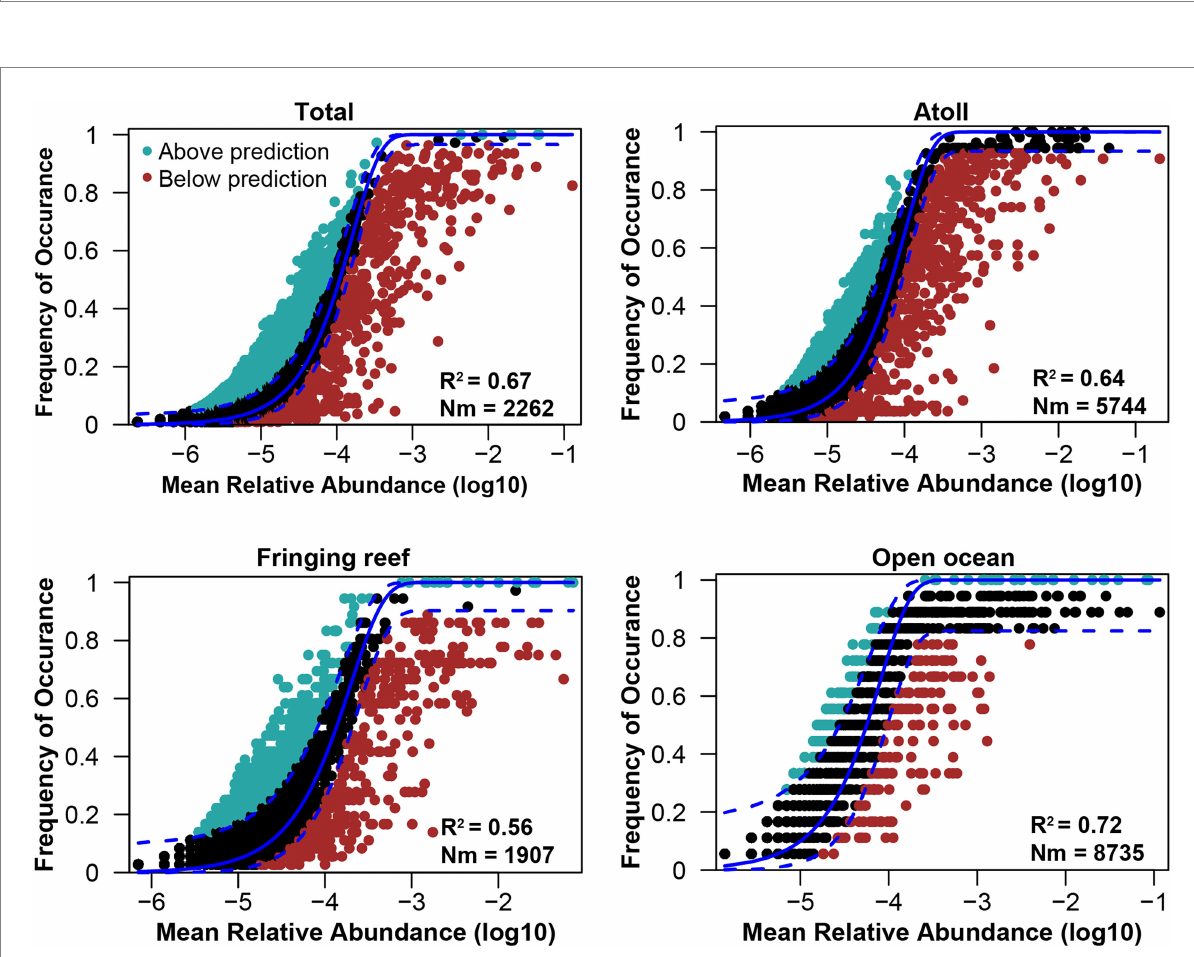
FIGURE 6 Fitting of the neutral model of bacterial community. R 2 indicates the fit to this model, Nm indicates the metacommunity size times